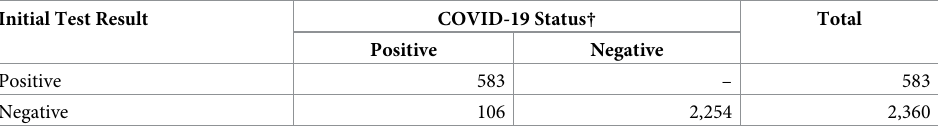
Table 4. rRT-PCR testing results � for individuals with specimens collected on more than one day ( n = 2,943) and received by Public Health Ontario, January 11, 2020 –April 22,